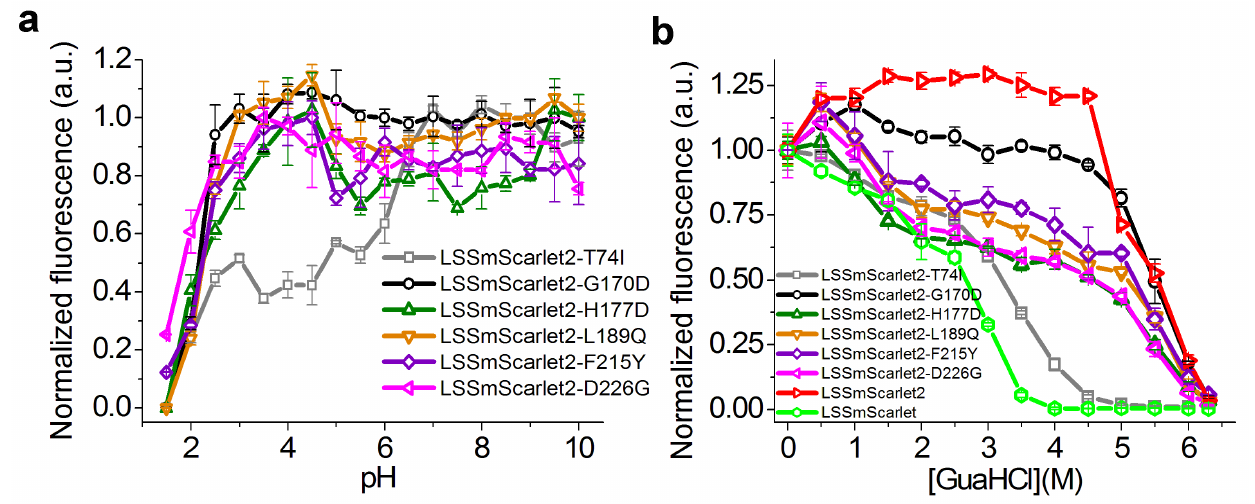
Figure 5. pH stability ( a ) and chemical stability in guanidinium chloride ( b ) of LSSmScarlet2 mu-